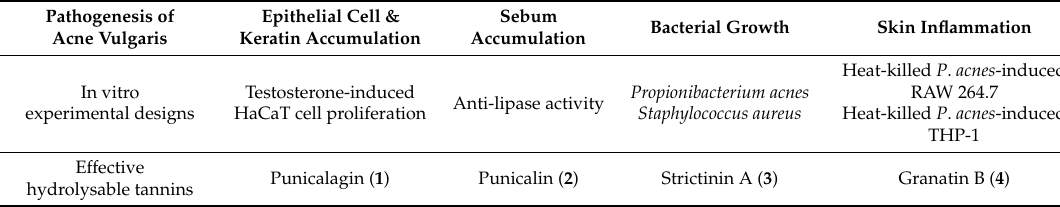
Table 1. The pathogenic mechanism of acne and experimental design of our